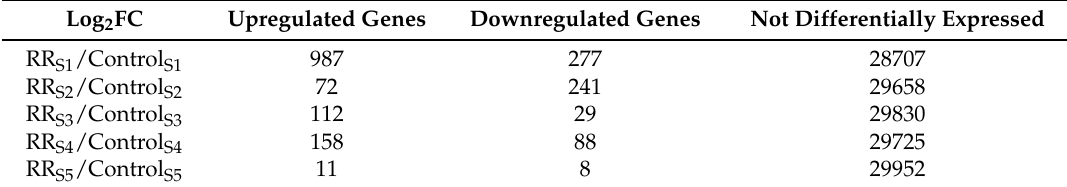
Table 2. Numbers of differentially expressed genes (FDR < 0.05 and Log 2 FC > 1) during developmental stages under root restriction treatment. FDR, false discovery rate; FC, fold